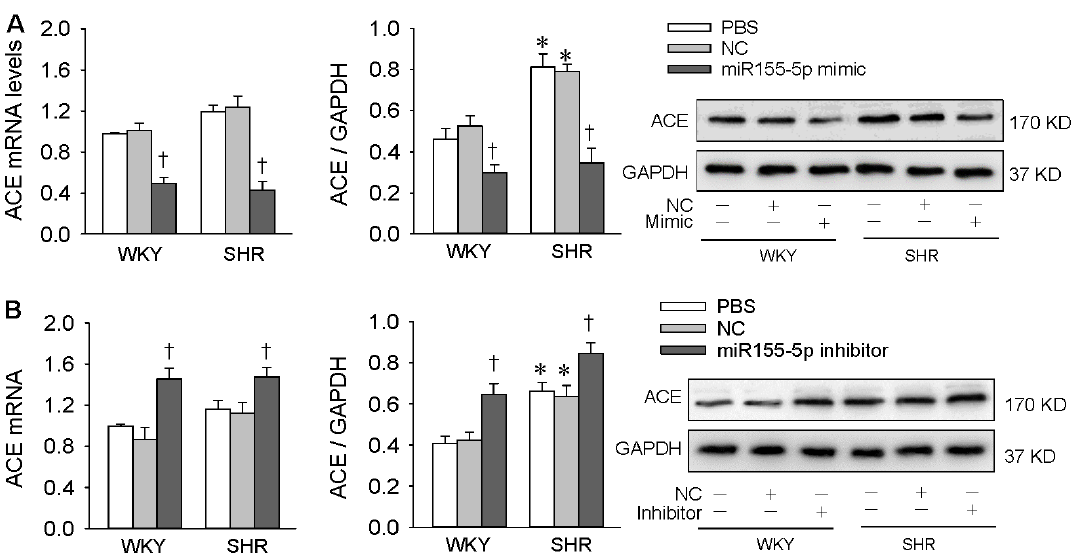
Figure 3. Effects of miR155-5p mimic and inhibitor on angiotensin-converting enzyme (ACE) mRNA and protein expression levels in VSMCs of WKY rats and SHR. VSMCs were treated with PBS, negative control (NC), miR155-5p mimic (50 nmol/L), or miR155-5p inhibitor (50 nmol/L. Measurements were made 24 h after transfection. ( A ) effects of miR155-5p mimic; ( B ) effects of miR155-5p inhibitor. Values are mean ± SE; * p < 0.05 vs. WKY; † p < 0.05 vs. PBS or NC; n = 4 per group.